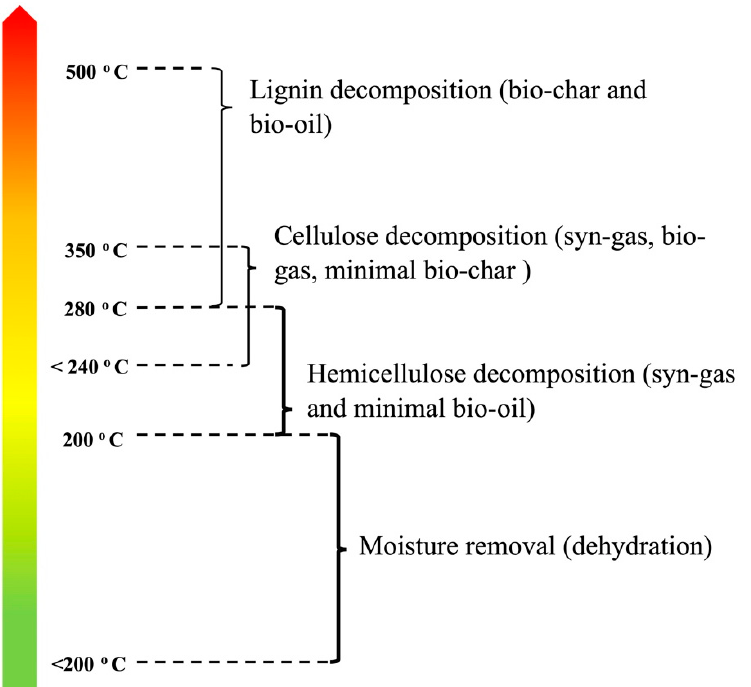
Figure 2. The decomposition processes and products of biomass components under different temperatures of pyrolysis. Modified from [31].